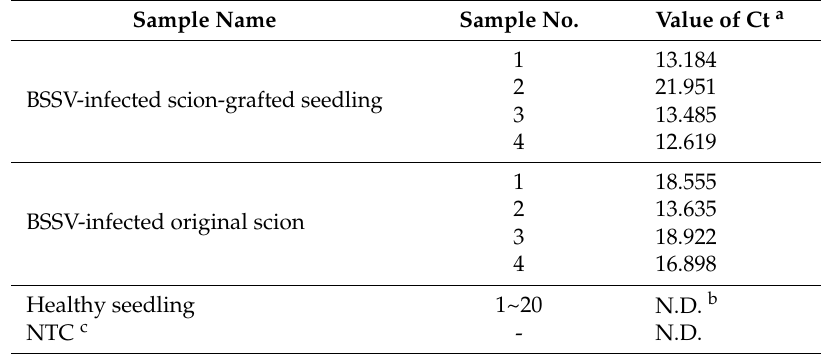
Figure 3. Reverse transcription-polymerase chain reaction (RT-PCR) products obtained from RNA extracted from BSSV-infected blueberry seedlings ( a ) Schematic representation of the genome structure of BSSV and the amplified region of the BSSV genome sequence after PCR using each primer pair. ORF1, movement protein; ORF2a, polyprotein (Protease-VPg); ORF2b, RNA-dependent RNA polymerase; CP, coat protein; ( b ) cDNA fragments of BSSV obtained by RT-PCR using each primer pair. Lane 1, Primers of BSSV-F1/BSSV-R2; Lane 2, BSSV-F2/BSSV-R3; Lane 3, BSSV-F3/BSSV-R4; Lane 4, BSSV-F4/BSSV-R4; Lane 5, BSSV-F4/BSSV-R5; Lane 6, BSSV-F5/BSSV-R5; Lane 7, BSSV-F6/BSSV-R6; Lane 8, BSSV-F7/BSSV-R6; M, 100-bp ladder marker. Table 2. Screening of BSSV grafted blueberry seedlings, BSSV sent blueberry scions and healthy blueberry nurseries using TaqMan real ‐ time RT ‐ PCR to assay for BSSV.